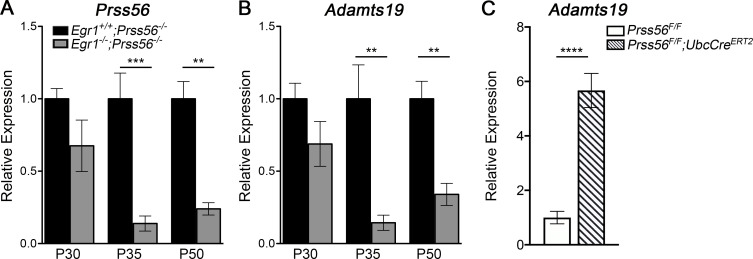
Egr1 inactivation prevents upregulation of retinal Prss56 and Adamts19 expression in Prss56 mutant mice.(A-B) Graphs showing quantification of Prss56 (A) and Adamts19 (B) mRNA levels using qPCR in Prss56 mutant (Egr1+/+;Prss56-/-) and Prss56;Egr1 double mutant (Egr1-/-;Prss56-/-) retina at different developmental stages. Egr1 inactivation reduced retinal Prss56 (A) and Adamts19 (B) mRNA levels in Prss56 mutant mice (compare Egr1+/+;Prss56-/-
to Egr1-/-;Prss56-/-). (C) Graphs showing quantification of Adamts19 mRNA levels using qPCR analysis in conditional Prss56 mutant mice in the absence or presence of the inducible ubiquitous Ubc-Cre transgene (Prss56F/F
or Prss56F/F;Ubc-CreERT2) showing upregulation of retinal Adamts19 following conditional Prss56 ablation by tamoxifen administration at P21. Data are presented as fold expression relative to wild-type (mean ± SEM), N = 4 to 6 retinas/group. **p<0.01; ***p<0.001, ****p<0.0005 t-test.